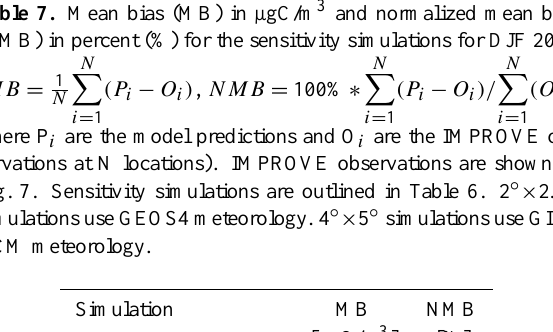
Table 7. Mean bias (MB) in µgC/m 3 and normalized mean bias (NMB) in percent (%) for the sensitivity simulations for DJF 2000